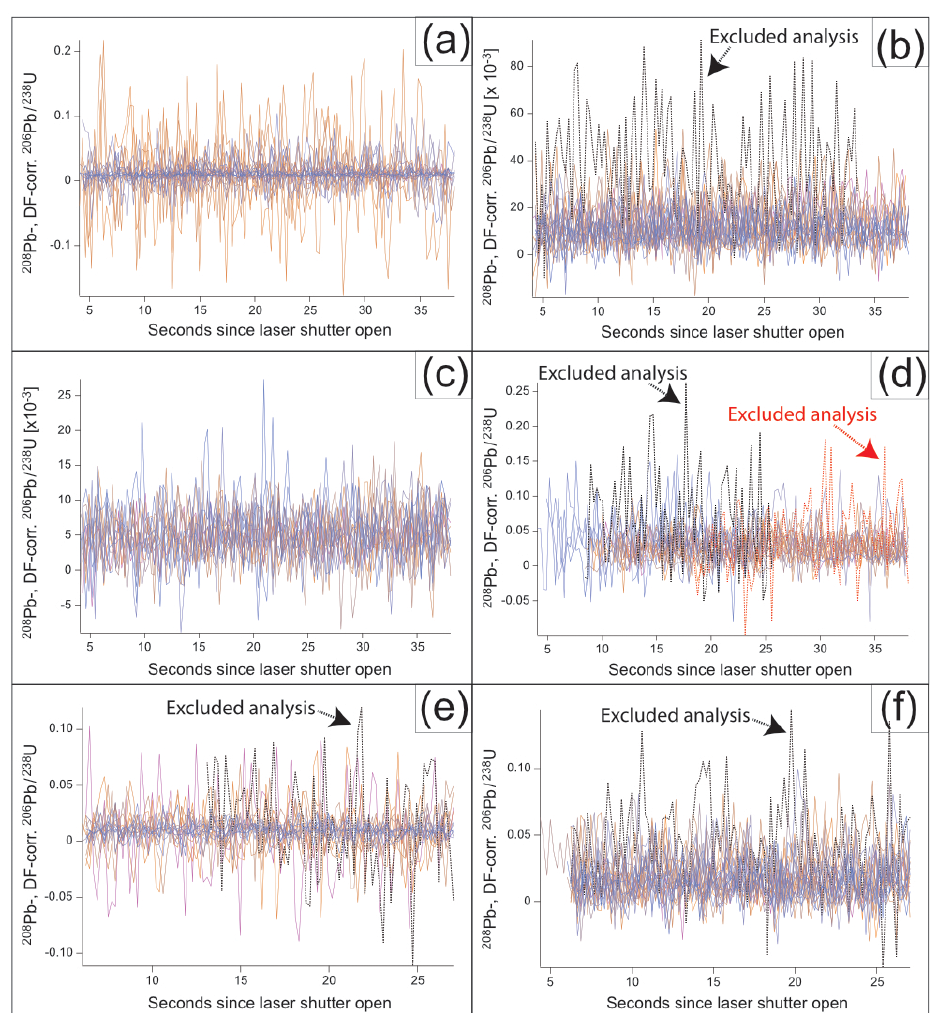
Figure 5. 208 Pb-corrected 206 Pb / 238 U ratios measured by LA-ICP-MS corrected for downhole fractionation (DF) of (a) Albula-1, (b) Grimsel-1, (c) Grimsel-2, (d) Heyuan-1, (e) Albula-1, and (f) Grimsel-1 epidote samples with Tara allanite as the primary reference material. Each individual line represents one analysis. Measurements are with spot sizes of 50µm (a–d) and of 30µm (e–f)